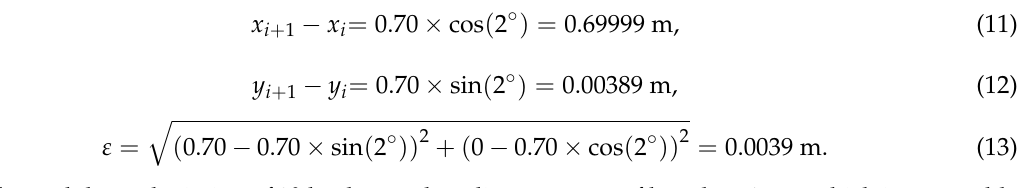
Table 4. Heading measurement values.